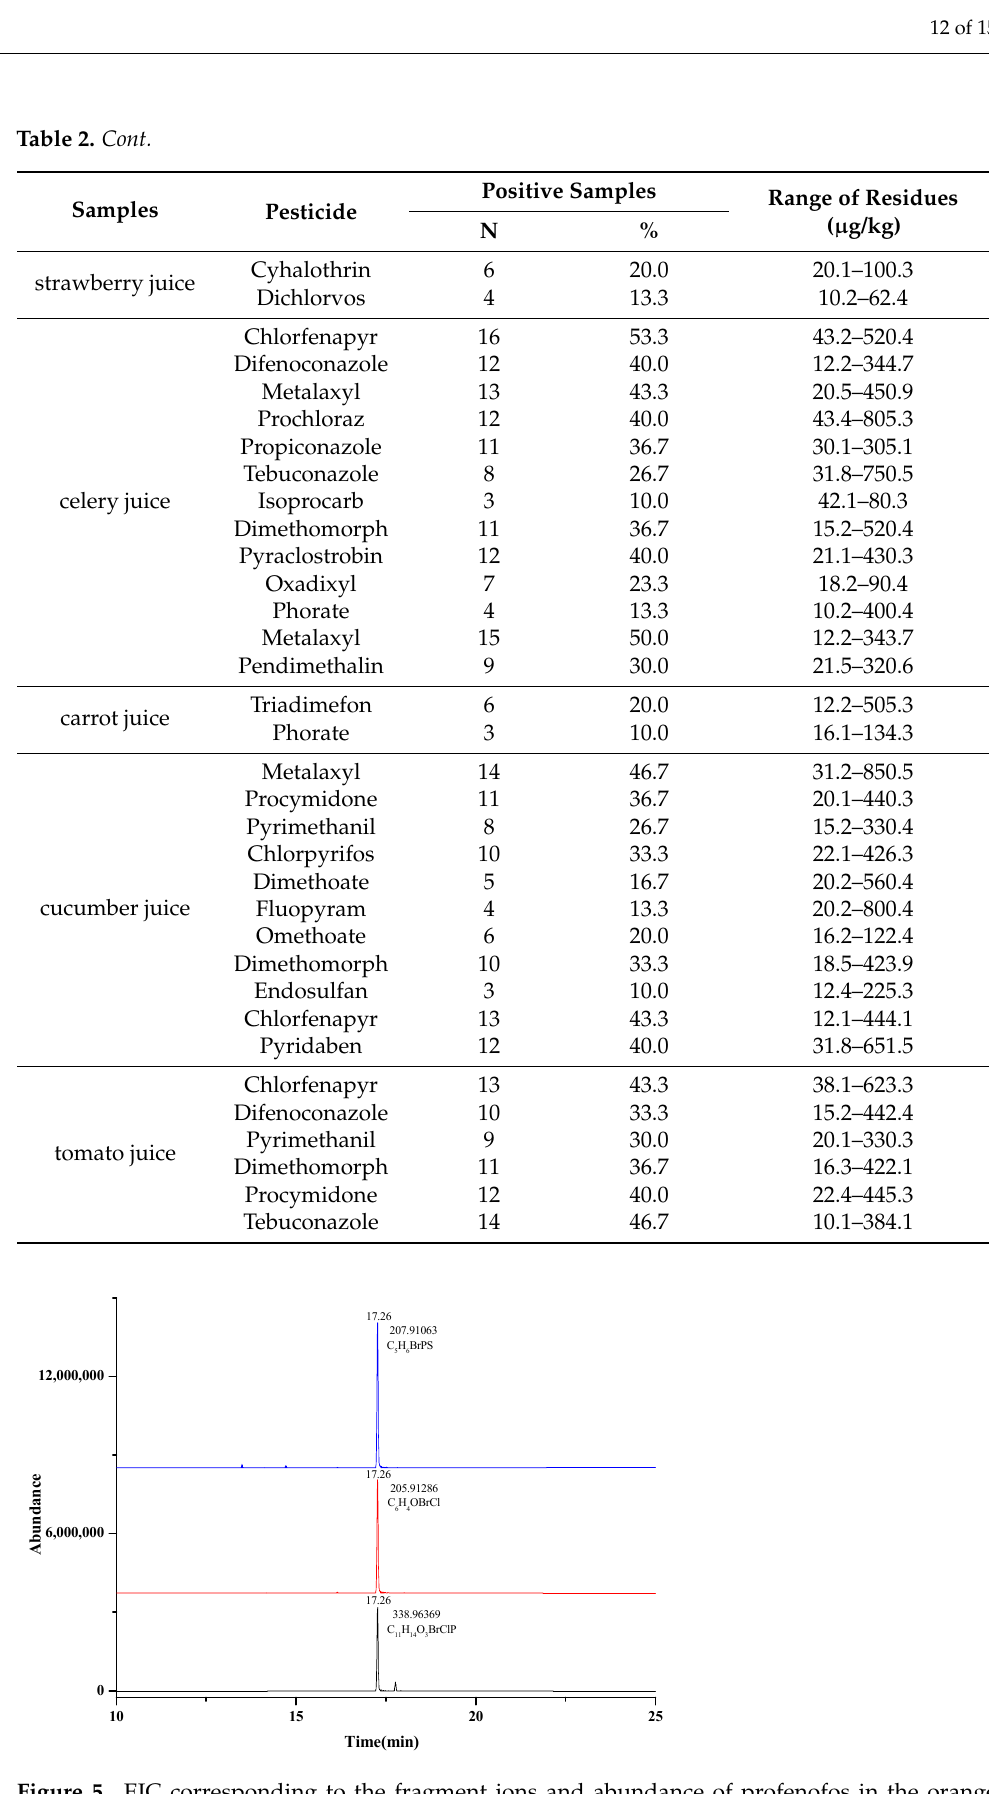
Figure 5. EIC corresponding to the fragment ions and abundance of profenofos in the orange juice